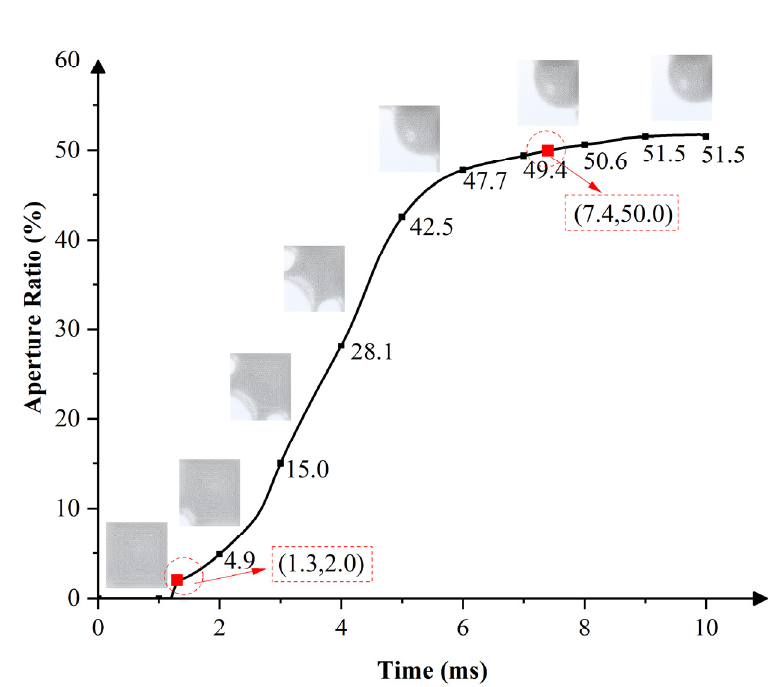
Figure 7. The switch-on response curve of an EWD pixel with a single-electrode pixel structure. The oil ruptured at 1.3 ms and the pixel reached a maximum aperture ratio of 51.7% at 9.5 ms, while 7.4 ms was required to reach an aperture ratio of 50%.